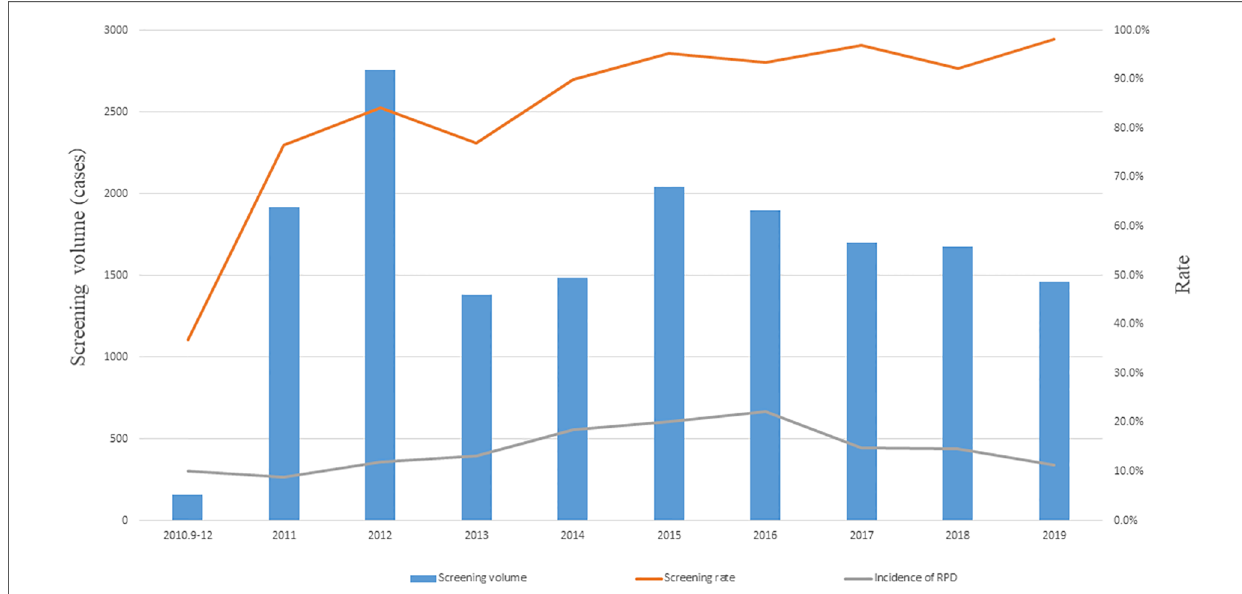
FIGURE 2 Screening volume, screening rate and incidence of RPD, from September 2010 to December